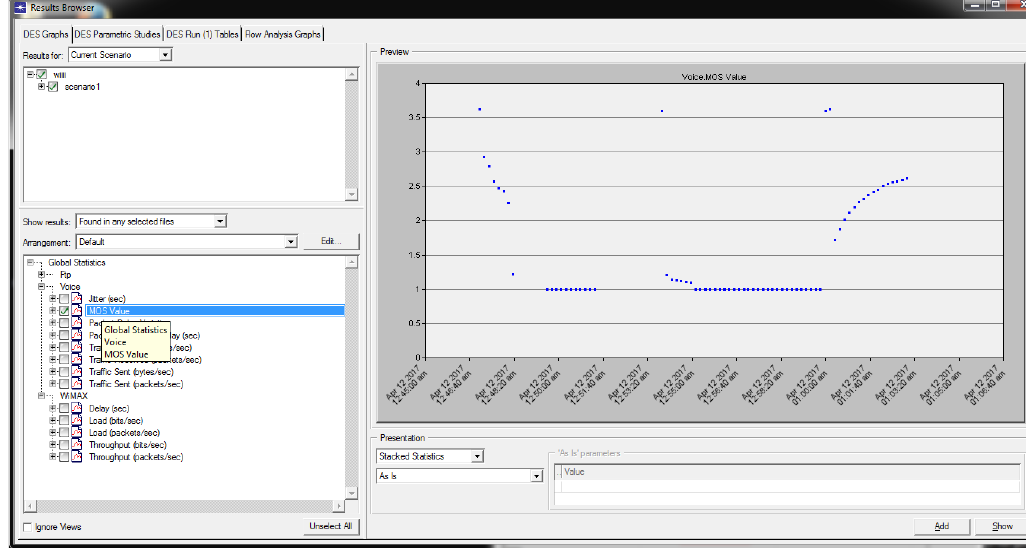
Fig. 7. Global Statistics WiMax VoIP MOS value for overall network, reaches 2.5 for maximum and 1 for minimum starts from the firs second of network